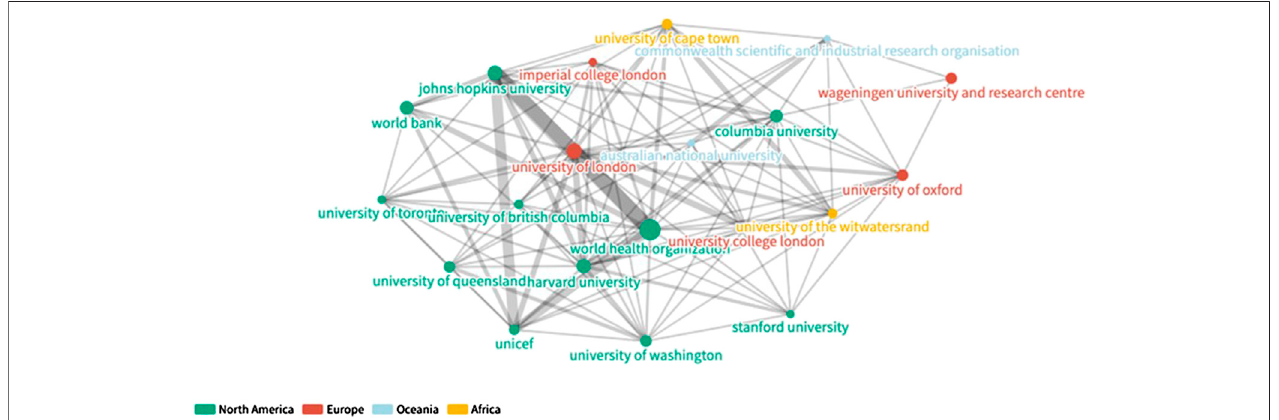
FIGURE 7 | SDG-research collaboration showing institutions with highest degrees,